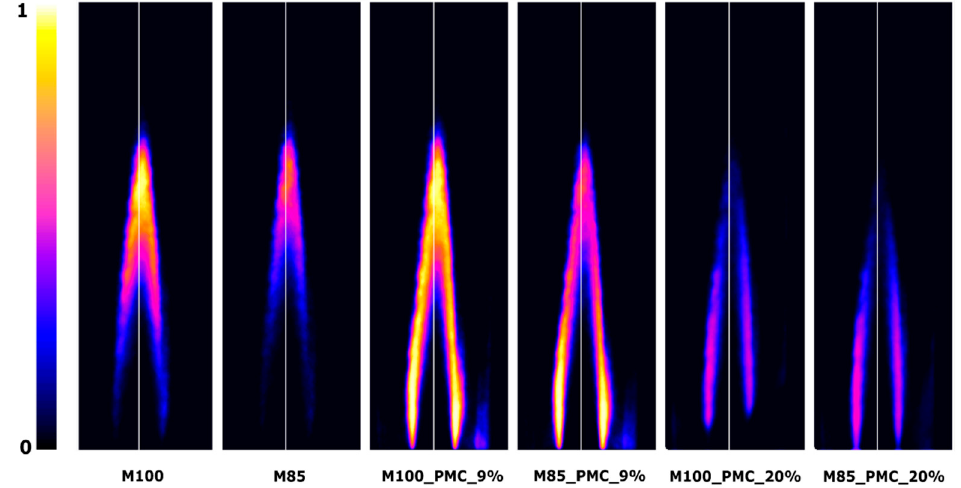
Figure 12. Examples of OH-PLIF images (scaled min–max) for M100 and M85 fuels, with PMC at 0.5 MPa and ϕ = 0.63.